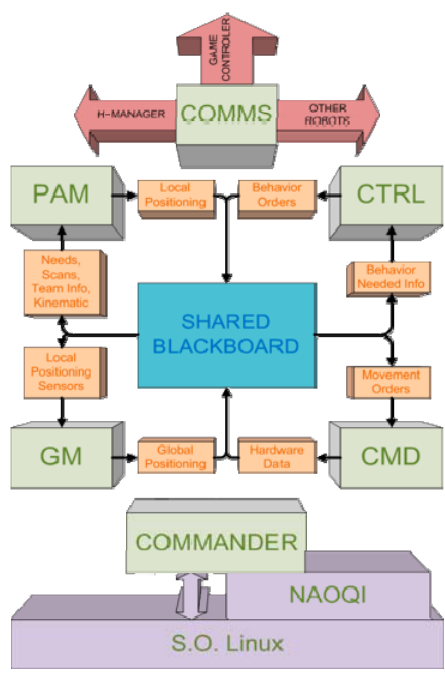
Figure 1. Hidalgos Team control system structure overview.